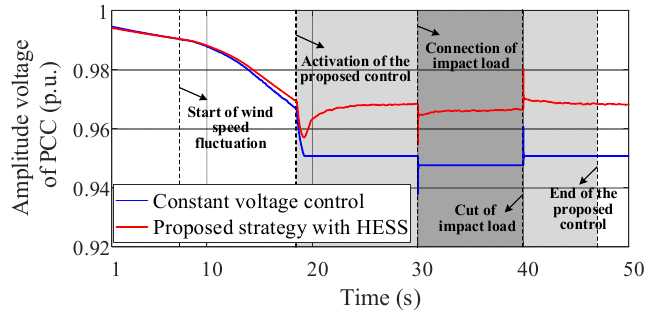
Figure 21. The voltage amplitude of PCC in case II.